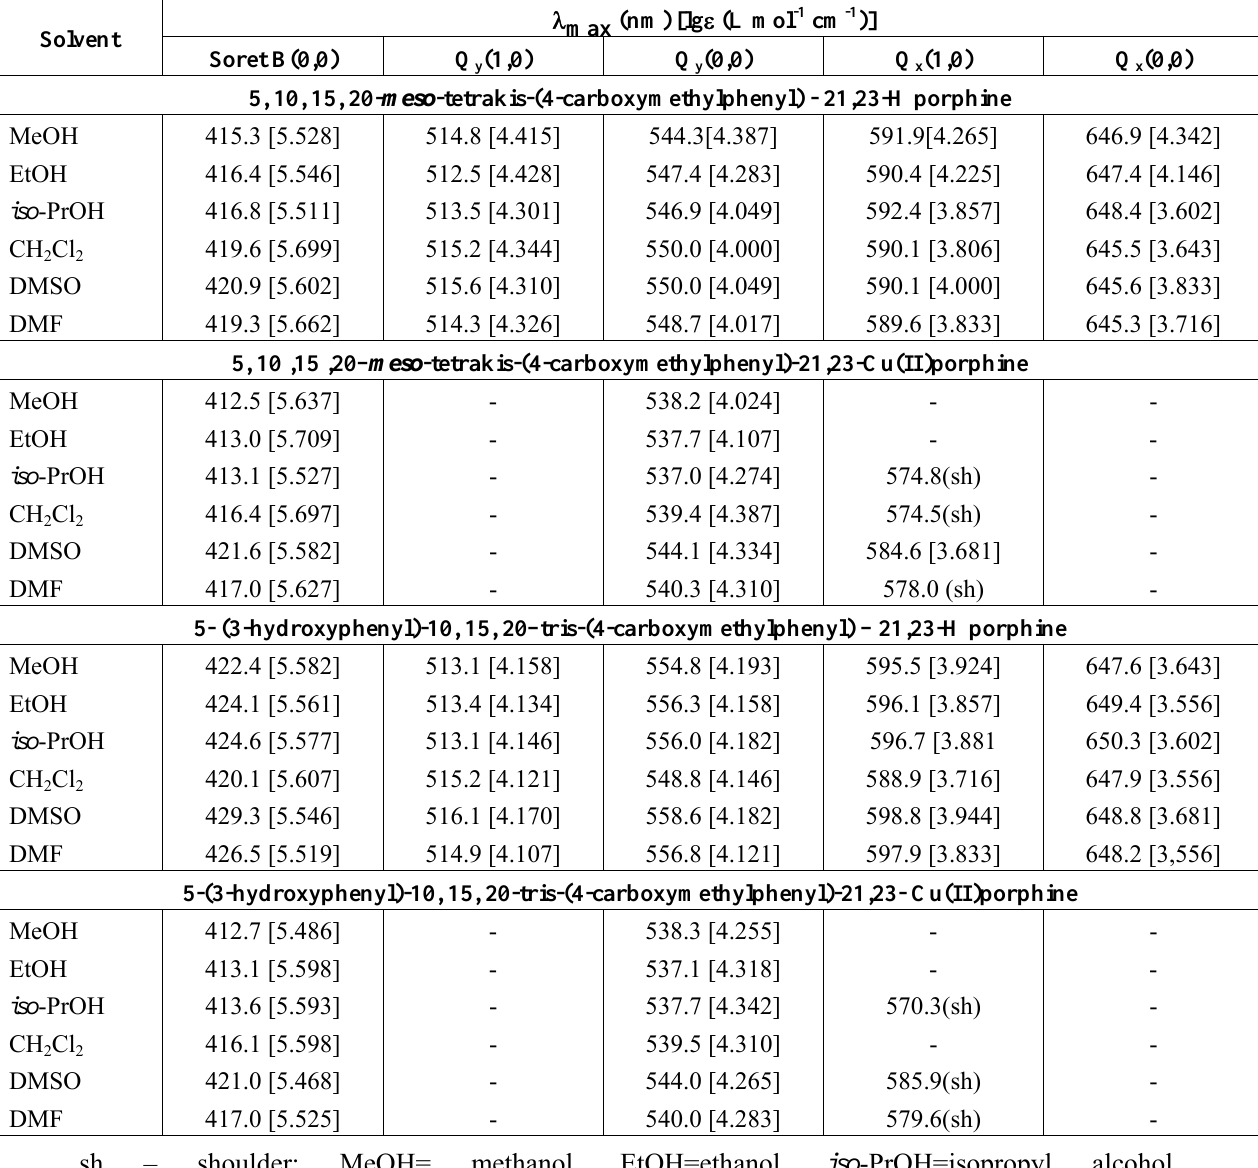
Table 2. Maximum wavelength and molar absorptivity of the porphyrinic ligands, Cu(II)TCMP and Cu(II)TCMPOH in different solvents (c = 2.5 × 10 -6 m